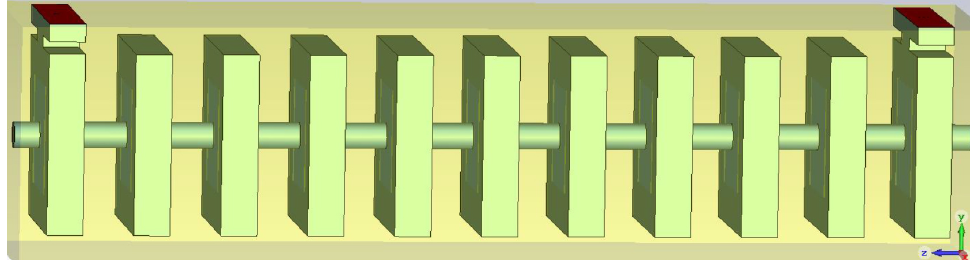
Figure 2. Perspective view of RRSC Klystron in CST microwave studio